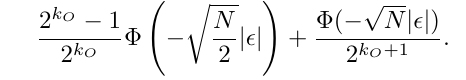
Algorithm 2C. After computing the statistic T ( κ, β, D ) for each ( κ, β ), pick out ( κ, β